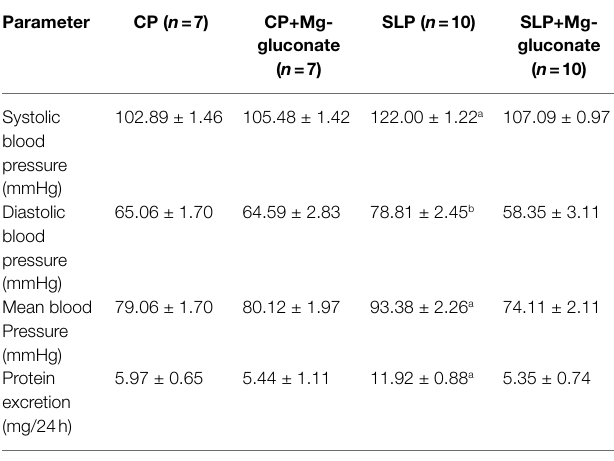
The data for blood pressure in this table corresponds to the 19th day of pregnancy. The 24 h urine was collected on the 21st day of pregnancy. Comparisons between treatment conditions were assessed by one-way ANOVA with the post-hoc analysis with the Student– Newman–Keuls test. In each row, value of p for the ANOVA test was